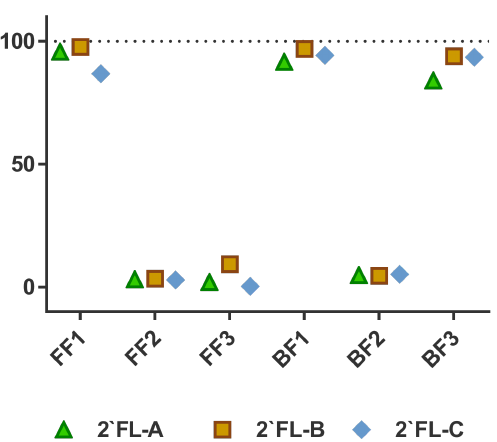
Figure 1. 2- (cid:48) fucosyllactose (2 (cid:48) FL) consumption (% of decrease in the levels of 2 (cid:48) FL from baseline values considered as 100%) by fecal cultures after 24 h of incubation, disaggregated by infant donor and 2 (cid:48) FL commercial preparation. FF: formula-fed fecal infant donor; BF: breastfed fecal infant donor. Numbers indicated the different infant donors. 2 (cid:48) FL-A was prepared by DuPont Nutrition and Health; 2 (cid:48) FL-B was from Friesland Campina (Aequival ® ): 2 (cid:48) FL-C was provided by Jennewein Biotechnologie